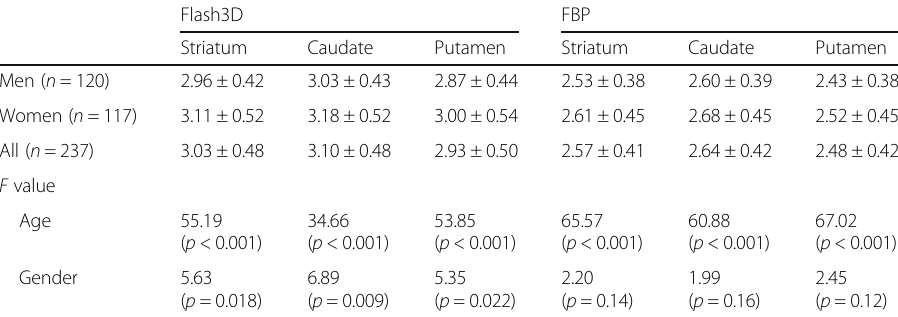
Values are mean±SD. F values and corresponding p values are presented for the effects of age and gender on SBR. SBRs specific binding